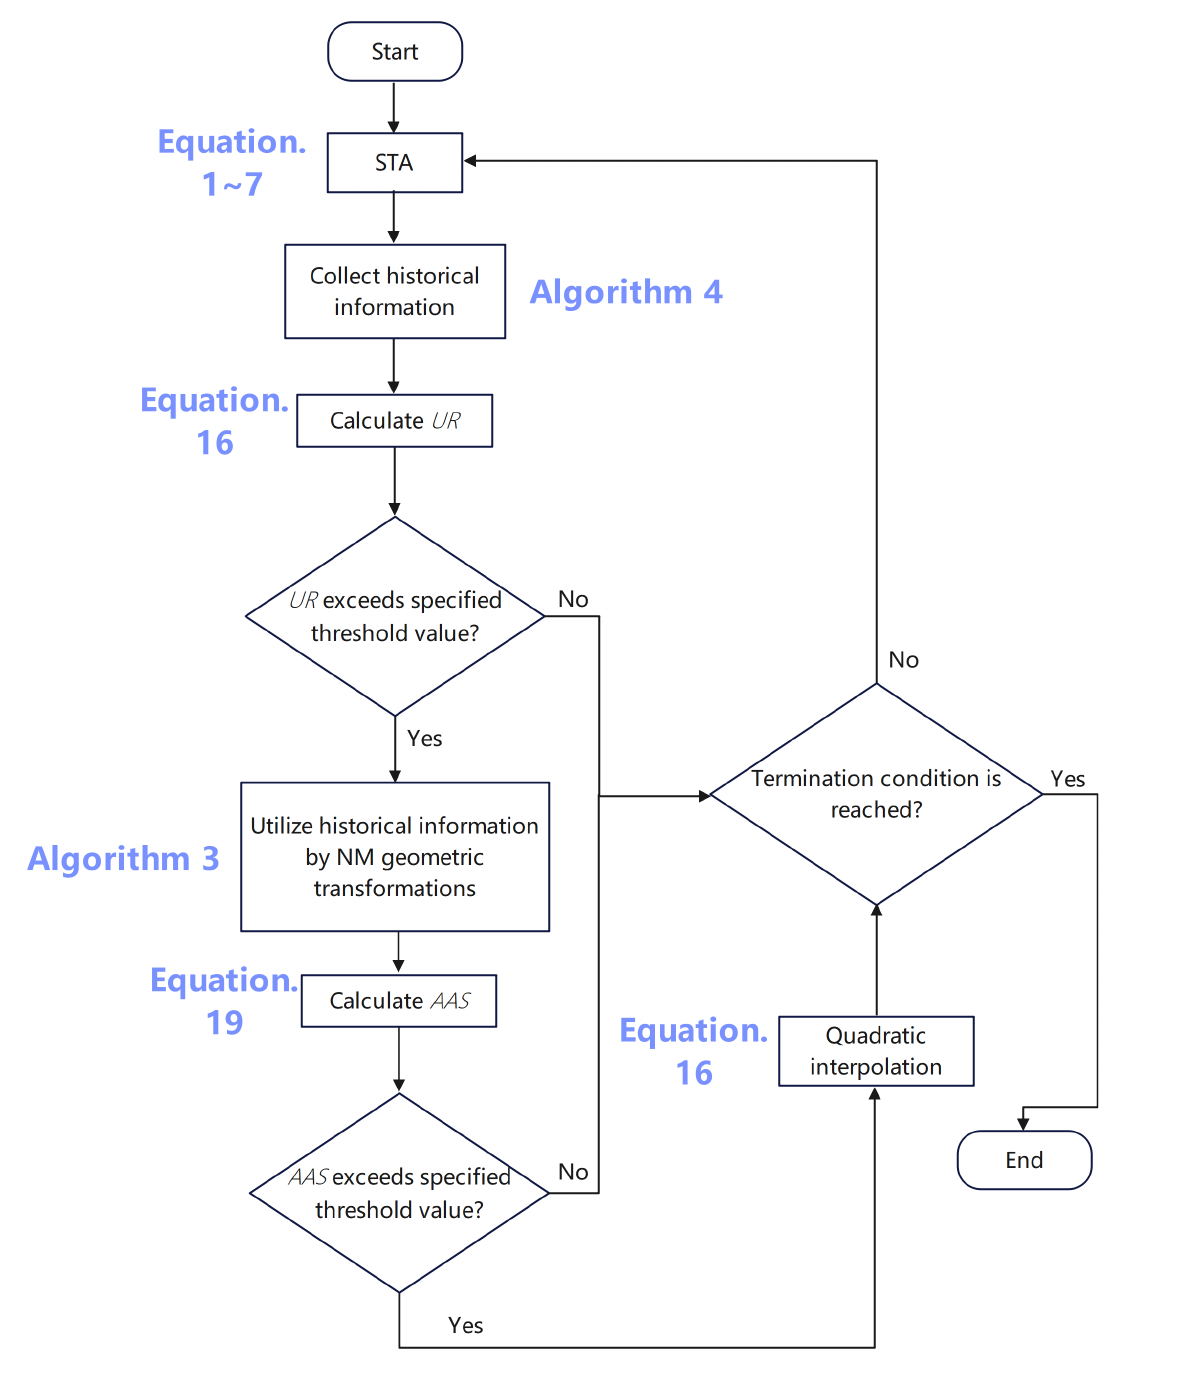
Figure 5. Flowchart of the enhanced hybrid